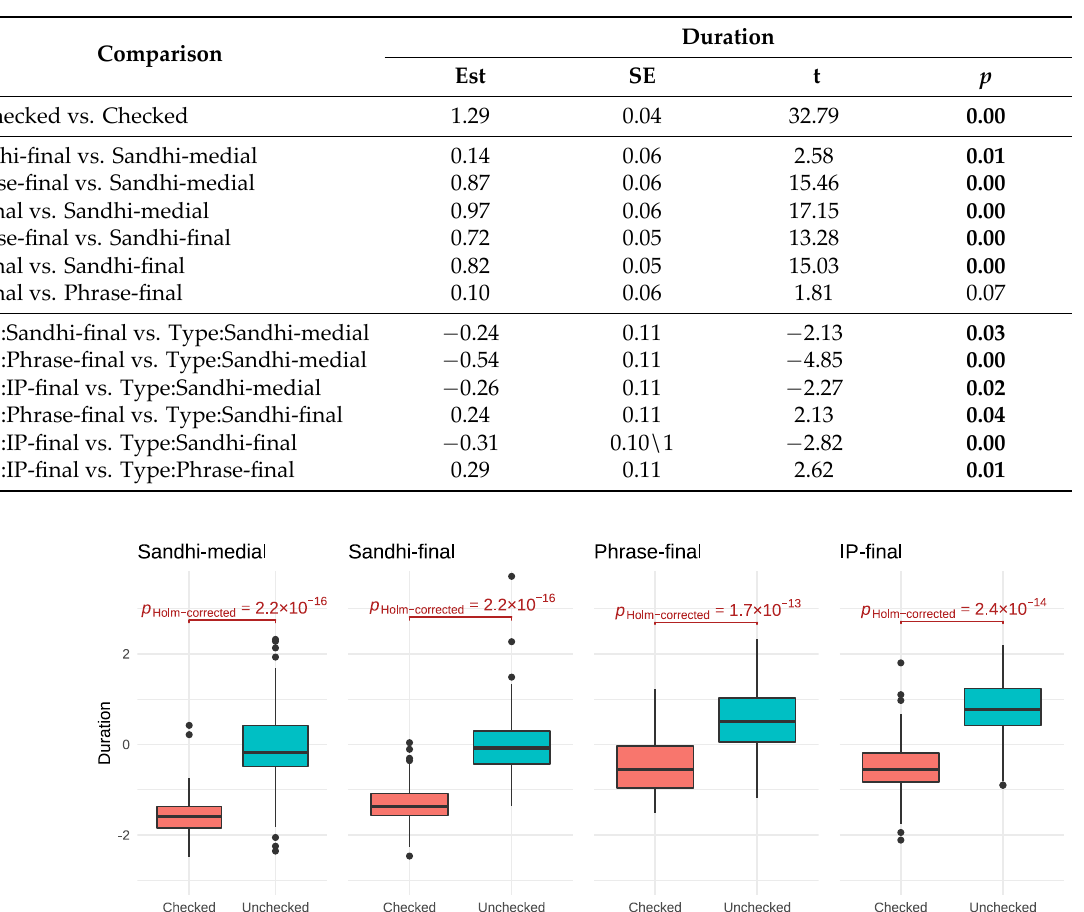
Table 7. Outputs of linear mixed‑effect regression for a duration with an interaction effect. Signifi‑ cant p ‑values ( p ⩽ 0.05 ) are marked in bold.